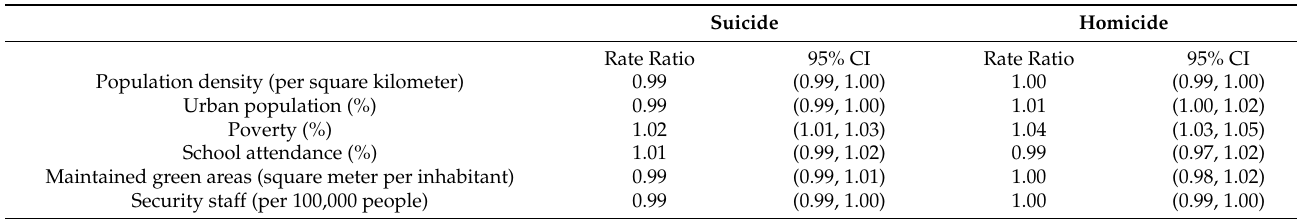
Table 4. Municipal level correlated for suicide and homicides in Chile,